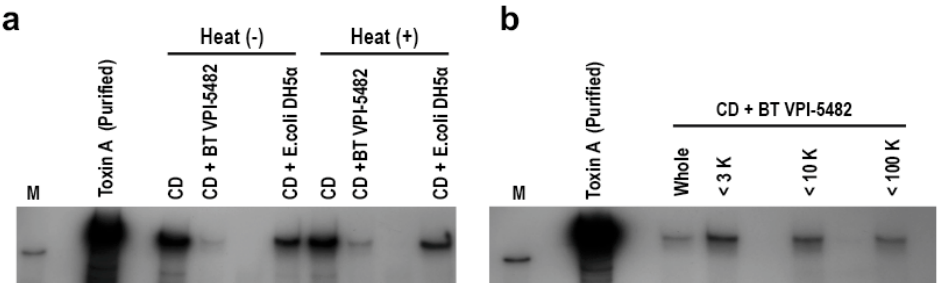
Figure 2. Characterization of BT-derived inhibitory factors on CD toxin production. ( a ) Heat stability was examined by heating the culture supernatant of BT or Escherichia coli DH5 α at 100 ◦ C for 10 min. After CD was cultured in either GAM broth or the conditioned media containing either heated- or unheated-culture supernatant, Toxin A level in the culture was compared by Western blotting with anti-Toxin A antibody. ( b ) Size fractionation of the culture supernatant of BT by Amicon ® ultrafiltration column. Filtration sizes are indicated above the lanes. “Whole” indicates the unfiltered sample. CD was cultured in the conditioned media prepared with either the filtered or unfiltered BT culture supernatant; Toxin A level in the culture was compared by Western blotting with anti-Toxin A antibody. M, HRP-labeled protein size marker (220 kDa).